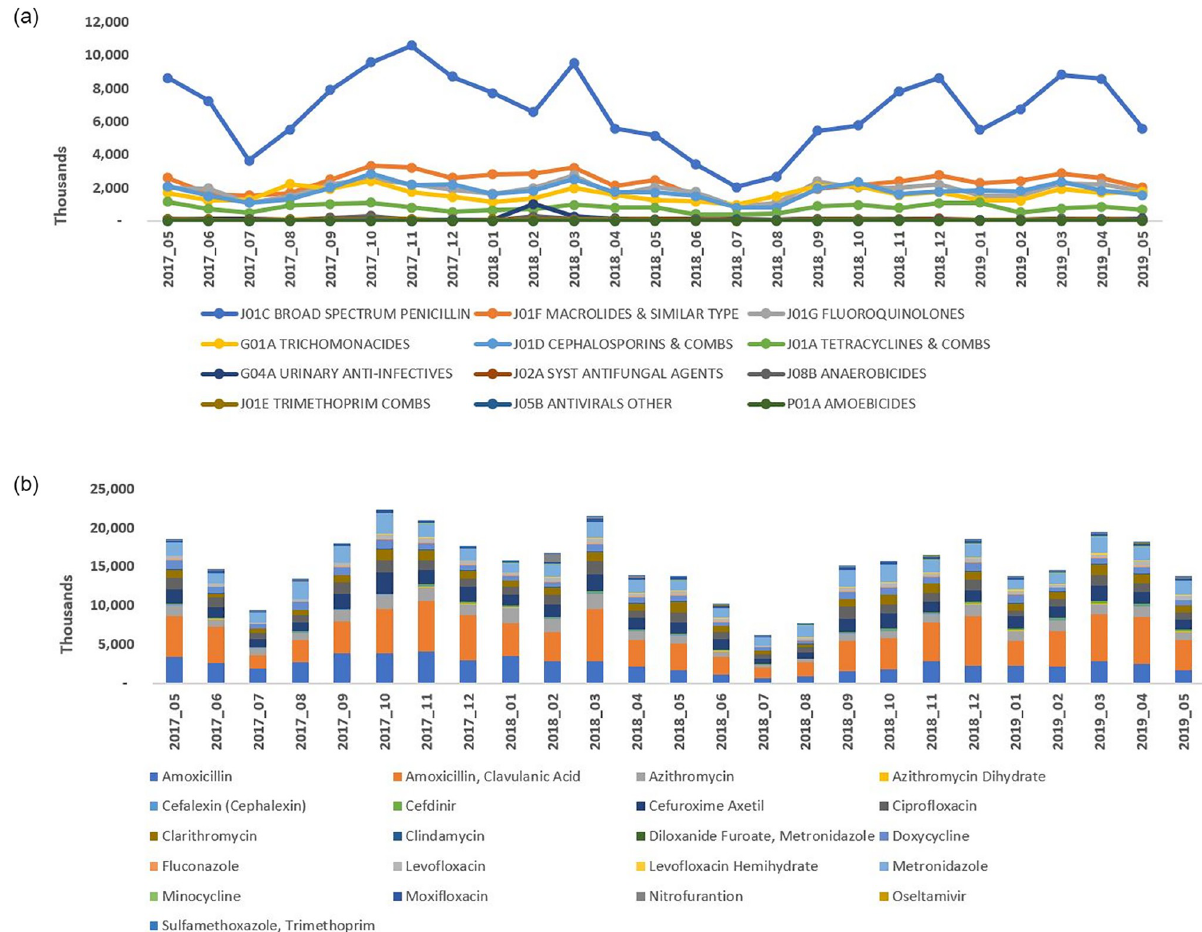
Fig 4. Antimicrobial utilization (DDD) in the year pre- and post-policy enforcement in Saudi Arabia. A] Antimicrobial utilization by chemical class, B] Antimicrobial utilization by molecule. DDD, defined daily dose.